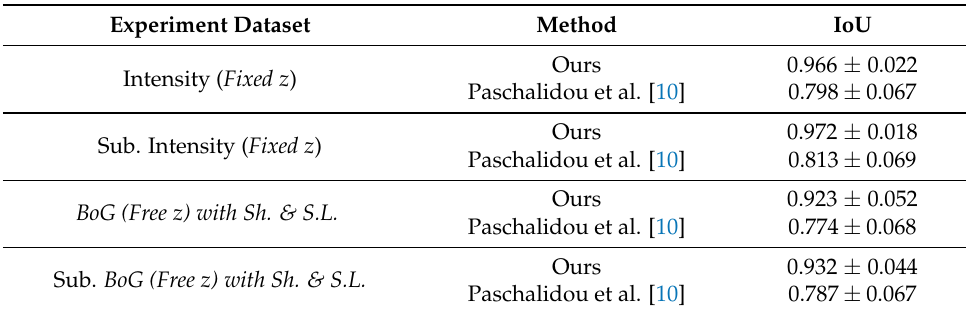
Table 2. Comparison with the state-of-the-art method of Paschalidou et al. [10] in terms of reconstruc- tion accuracy. The table reports the mean and standard deviation values achieved on two different datasets and their subsets (labeled Sub.). The abbreviations Sh. and S.L. denote the addition of shadows (Sh.) and a spotlight (S.L.) source,